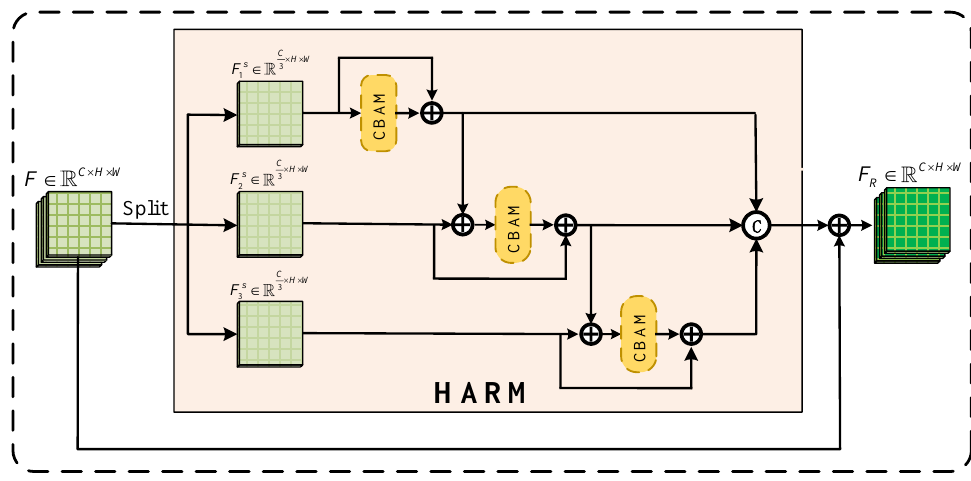
Figure 3. Architecture of Hierarchical Attention Residual Module